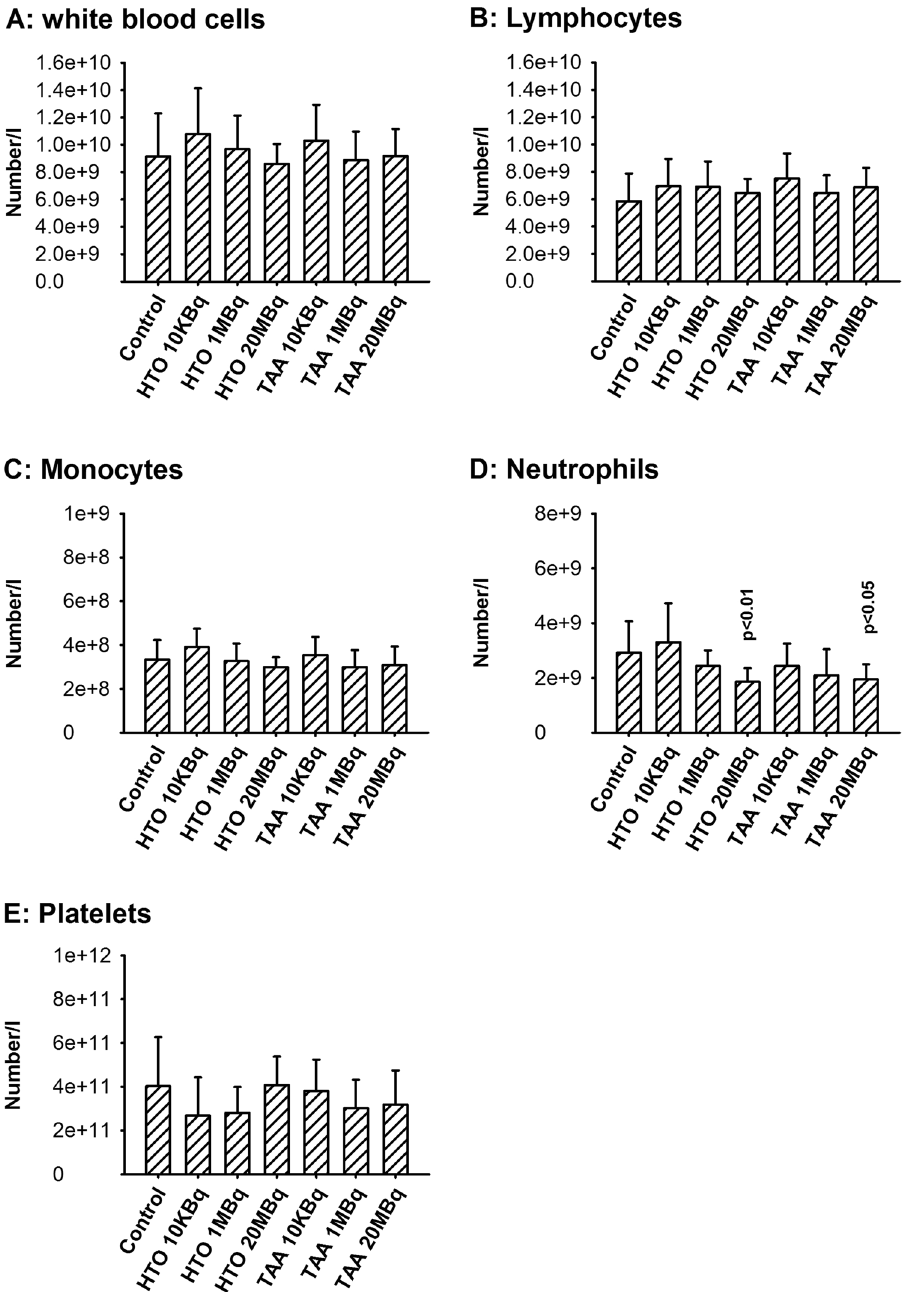
Figure 1. Blood cell counts and differentials in animals after one month of exposure to either HTO or TAA. ( A ) White blood cells; ( B ) lymphocytes; ( C ) monocytes; ( D ) neutrophils; ( E) platelets. Results are mean ± SD, n = 11. No significant differences were observed in the different exposure groups using a one-way ANOVA test except for neutrophils (H (6) = 16.5, p = 0.011), for which significant differences with the control group are